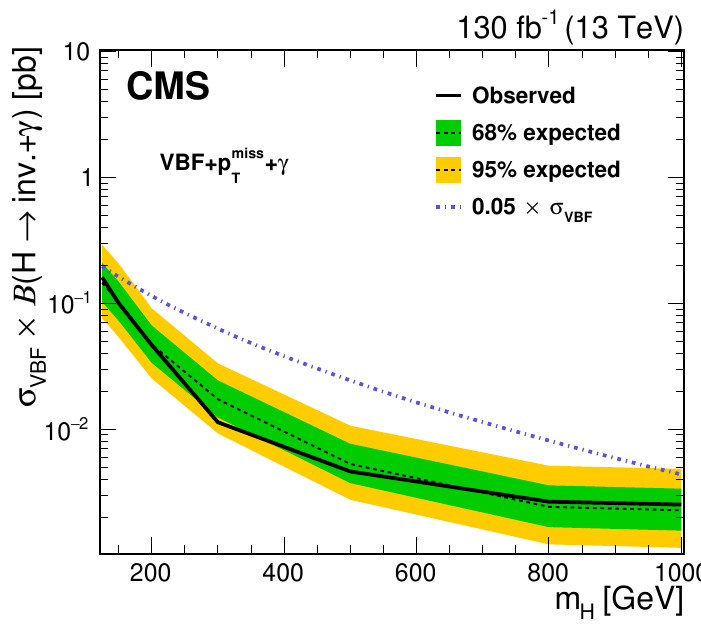
Figure 4 . Expected and observed upper limits at 95% CL on the product of σ inv. + γ ) as a function of m . The dot-dashed line shows the predicted signal corresponding to H 0 . 05 σ , assuming SM couplings. A linear interpolation is performed between the values obtained VBF for the probed m H